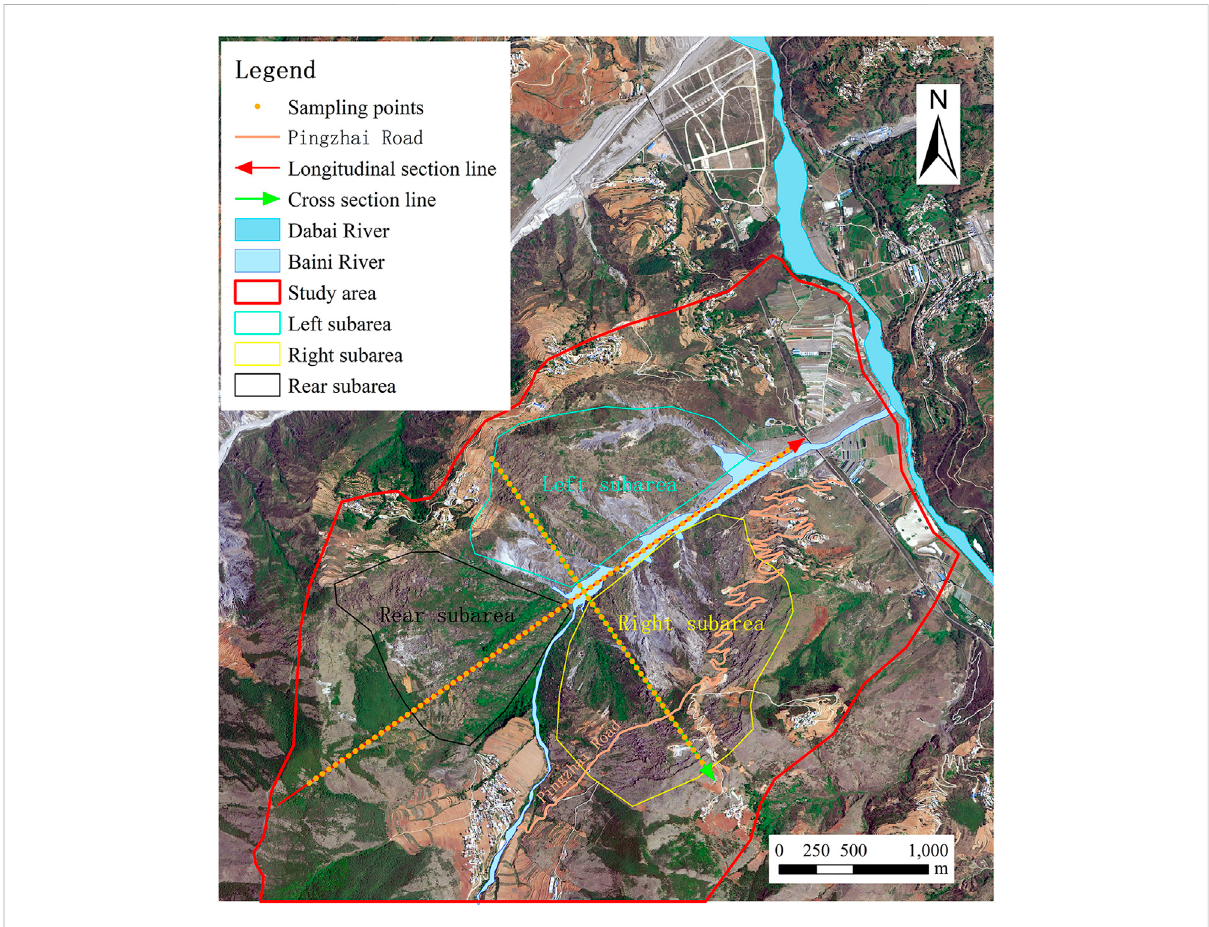
FIGURE 5 The distribution map of sampling points in the debris fl ow source